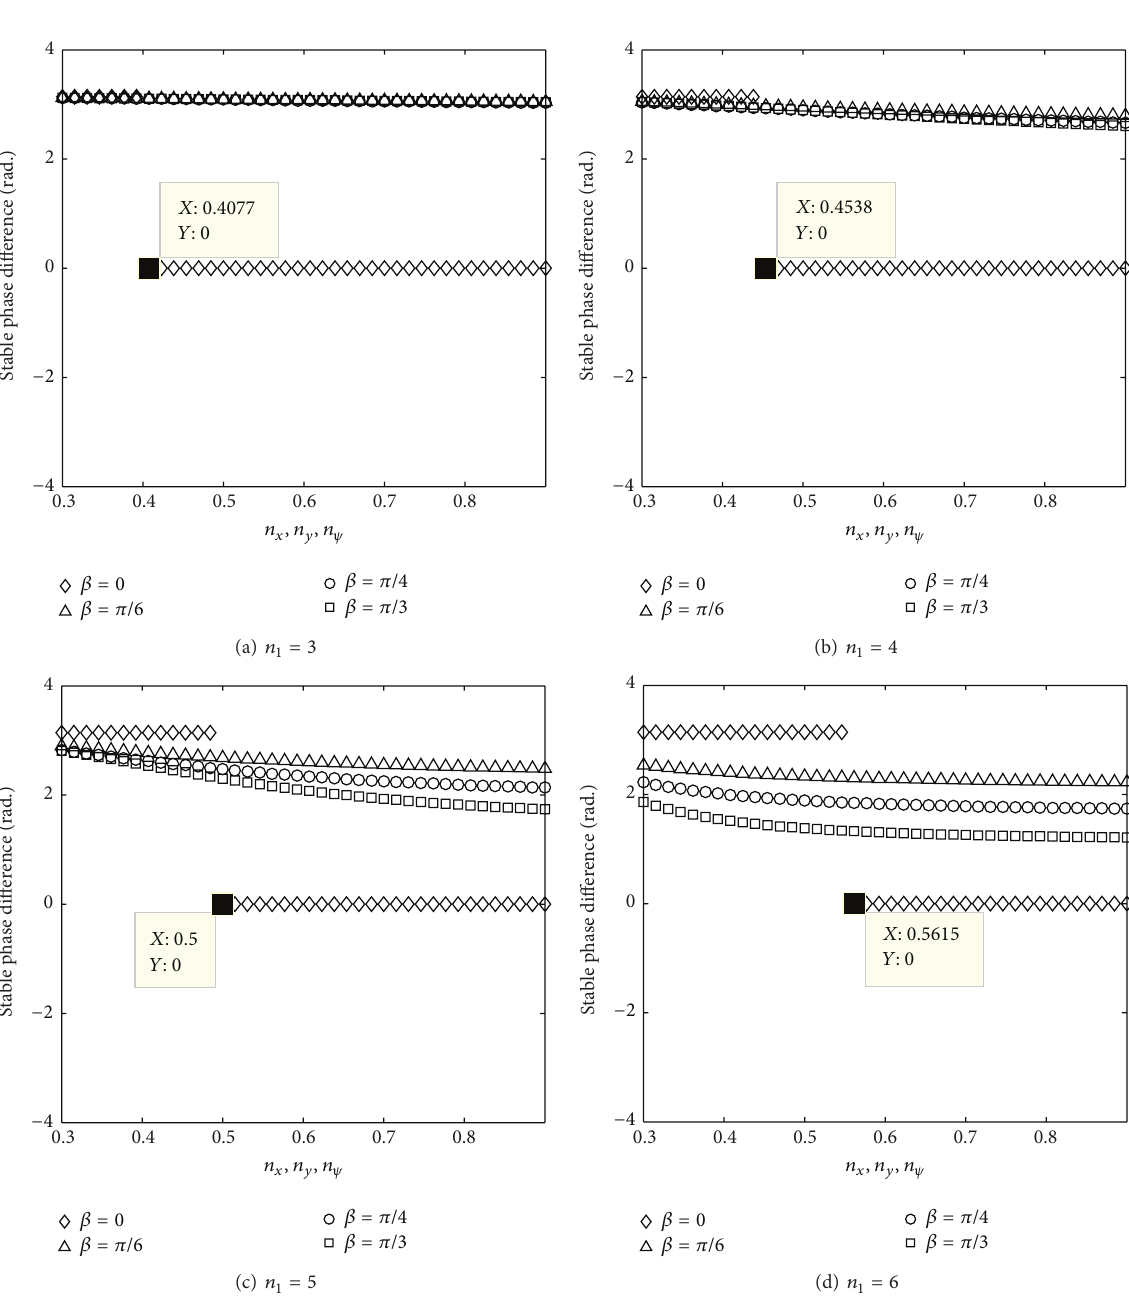
Figure 8: Stable phase difference for SACWA assuming the nonidentical mass of rotors and considering 𝜂 13 = 5 , 𝜂 23 = 1 , 𝑛 𝑥 ≈ 𝑛 𝑦 ≈ 𝑛 𝜓 = 5.0 , = 0.08 , and 𝑙 = 0.3 : (a) 𝑛 = 3 , (b) 𝑛 = 4 , (c) 𝑛 = 5 , and (d) 𝑛 = 6 𝑟 𝑙 𝑒 1 1 1 1